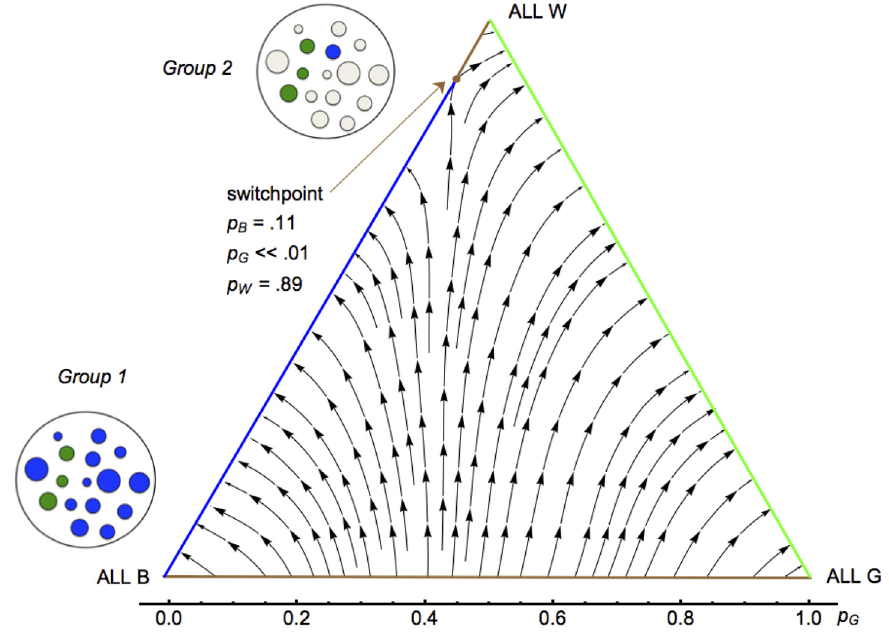
Fig 4. Three types. Stream plot of selection vectors for populations with fractions p B , p G , and p W playing Almost Balanced Reciprocity, Generalized Reciprocity, and a Weighted Compromise. Fitnesses are proportional to net benefits, averaged over random samples of mixed groups of 40 players with coefficient of relatedness r = .06. Blue line shows a neutrally stable mix of B and W players, green line a neutrally stable mix of G and W players. At switchpoint, the mixture of B and W is unstable: population leaves B/W equilibrium for G/W, never to return. Group 1 : Typical group composition experienced by a rare G player and her relatives when type W is absent. Type G (green circles; size stands for ability) is outnumbered by type B (blue circles). Group 2 : Typical group composition experienced by a rare G player and her relatives when type W is common. G player and her G relatives outnumber type B; type W players (white circles) skew their play toward Generalized Reciprocity, amplifying small r